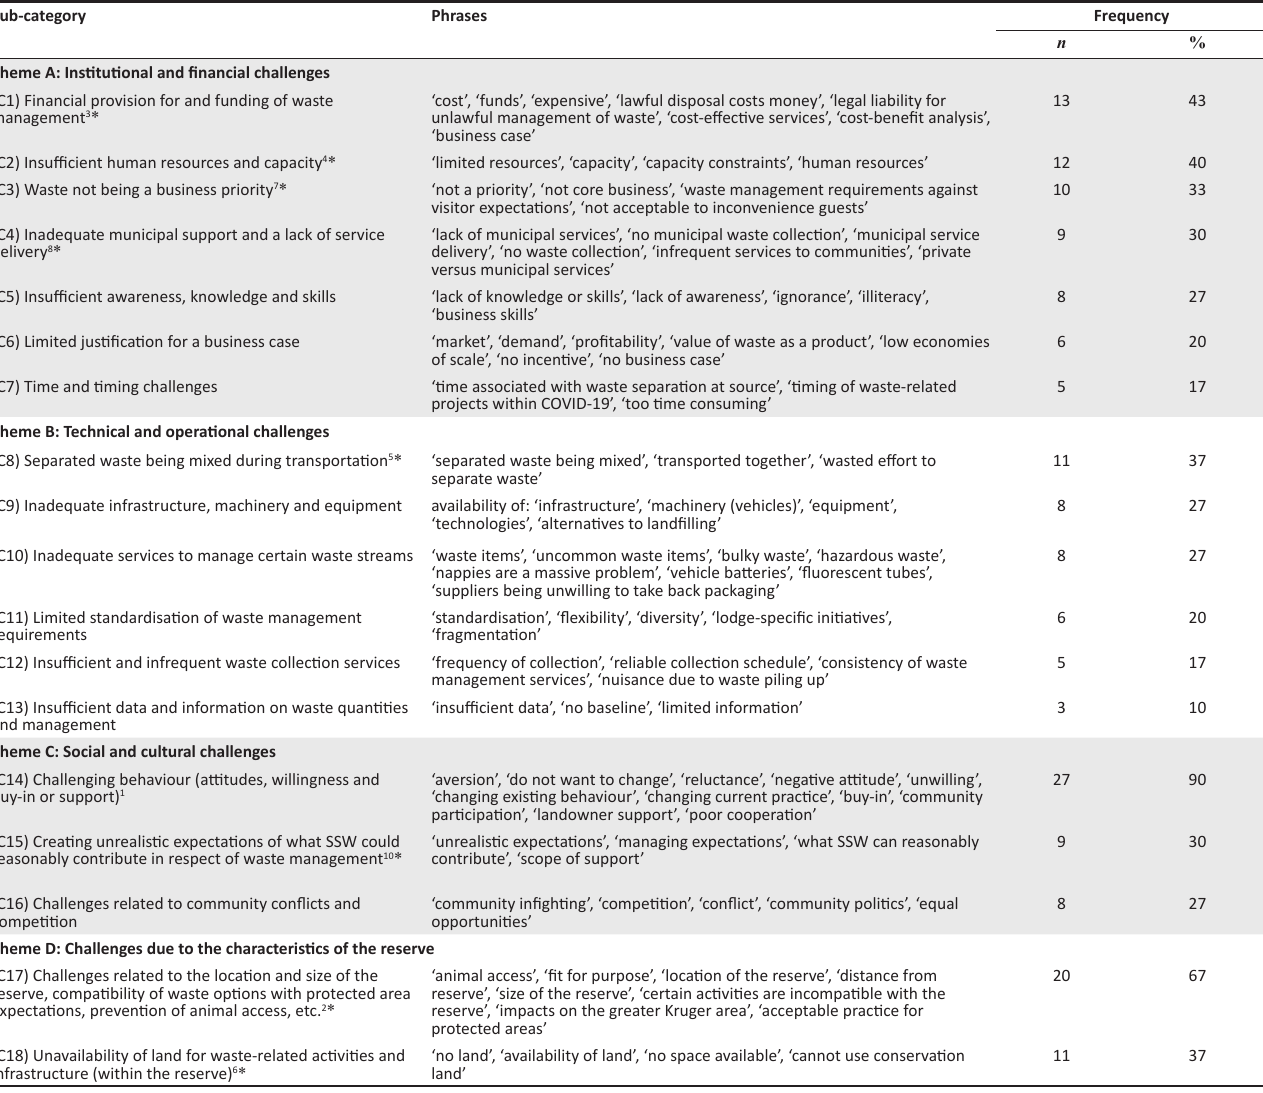
TABLE 1: The number (and percentage out of a total of 30 participants) of responses per code as it relates to the perceived challenges for sustainable solid waste management in the private nature reserve.